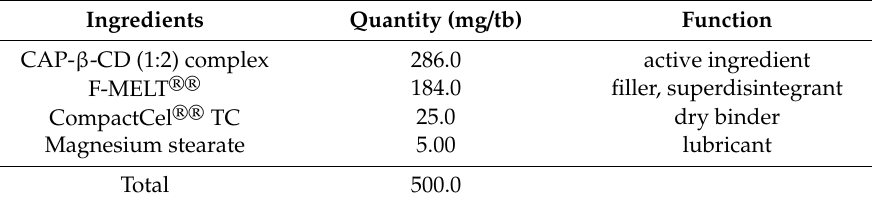
Table 1. Composition of the developed captopril- β -cyclodextrin (CAP- β -CD) tablets. Ingredients Quantity (mg / tb)